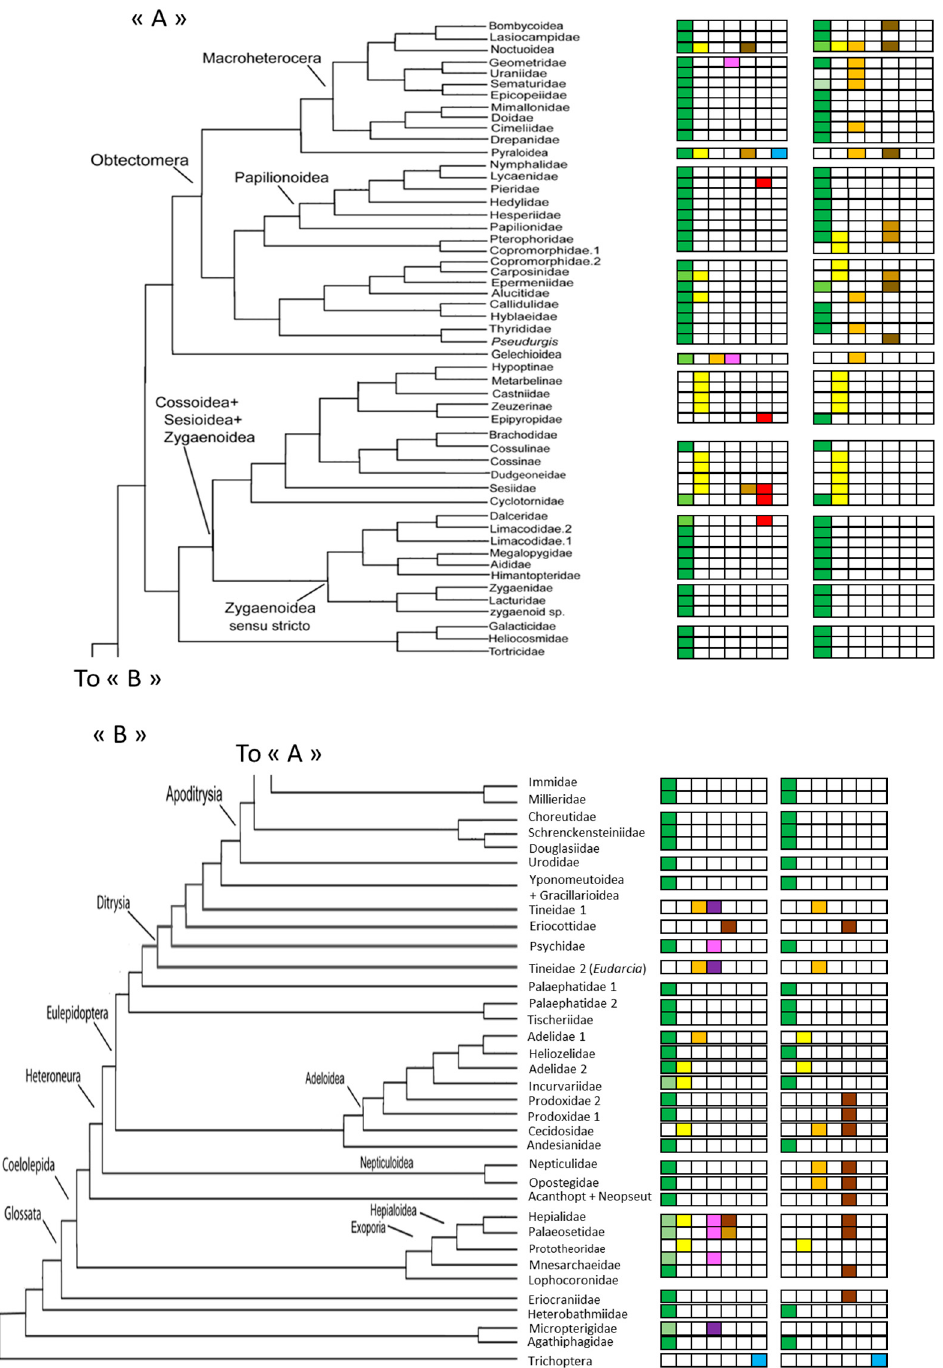
Figure 1. Phylogeny of Lepidoptera (Separated into “ A ”, “ B ” for readability) modified from [37] and the main environmental uses of caterpillars (left) and pupae (right). For each category, the intensity of the colour is related to the number of species using a particular resource (Deep colour: majority of species, pastel colour: less than 40% of species). Green: leaf use, yellow: stems or wood, orange: litter, purple/pink: fungi, brown: soil, red: carnivores or nymphs in anthills, and blue: